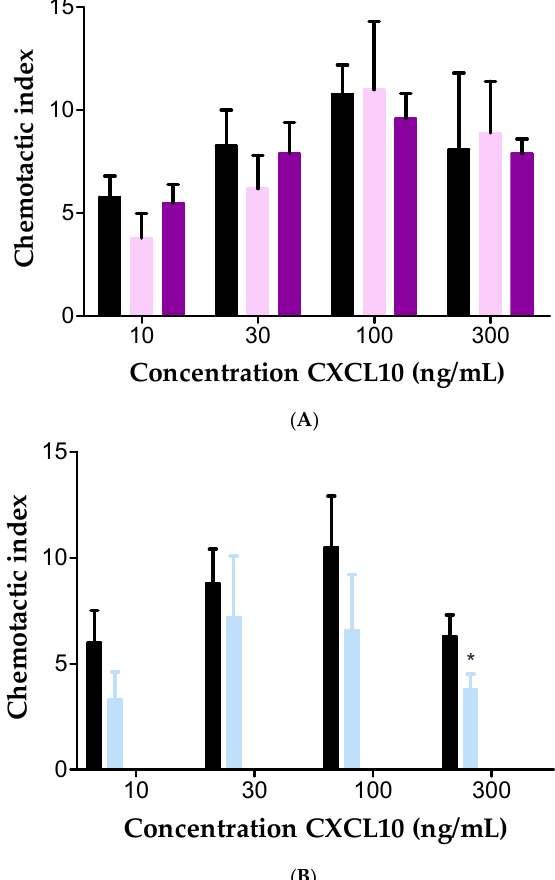
Figure 5. Effect of GAGs on CXCL10-induced T cell chemotaxis in vitro. The effects of: 0.04 µg/mL (light violet, ● ), or 4 µg/mL (violet, ● ) soluble heparan sulfate ( A ); or 4 µg/mL (light blue, ● ) heparin ( B ) on the in vitro migratory response of PHA-activated T cells towards10–300 ng/mL CXCL10 was